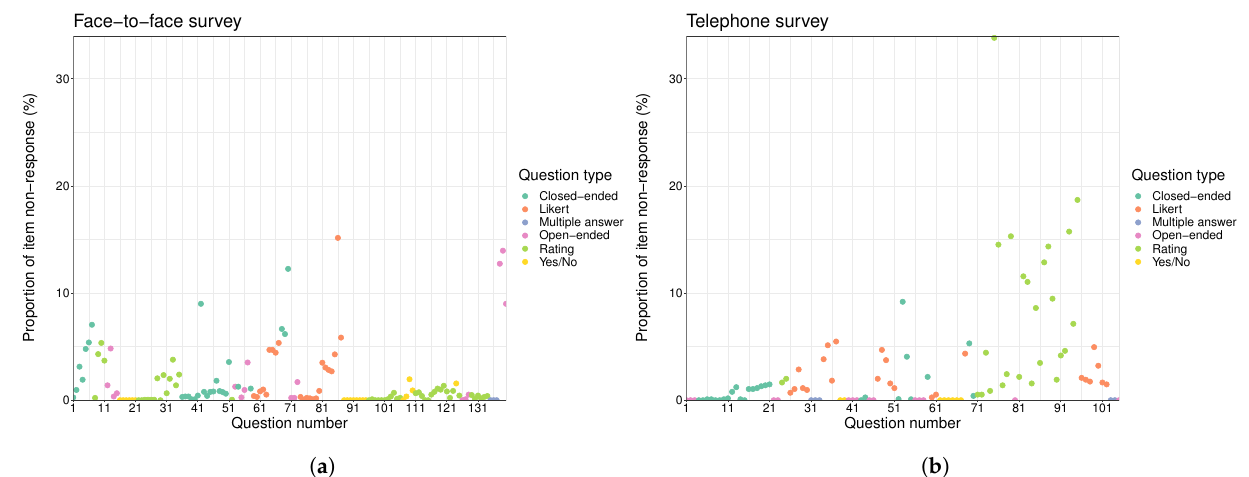
Figure 2. Proportion of item non-response observed for each of the questions included in the face-to-face ( a ) and the telephone survey ( b ) studied. The points are coloured according to question